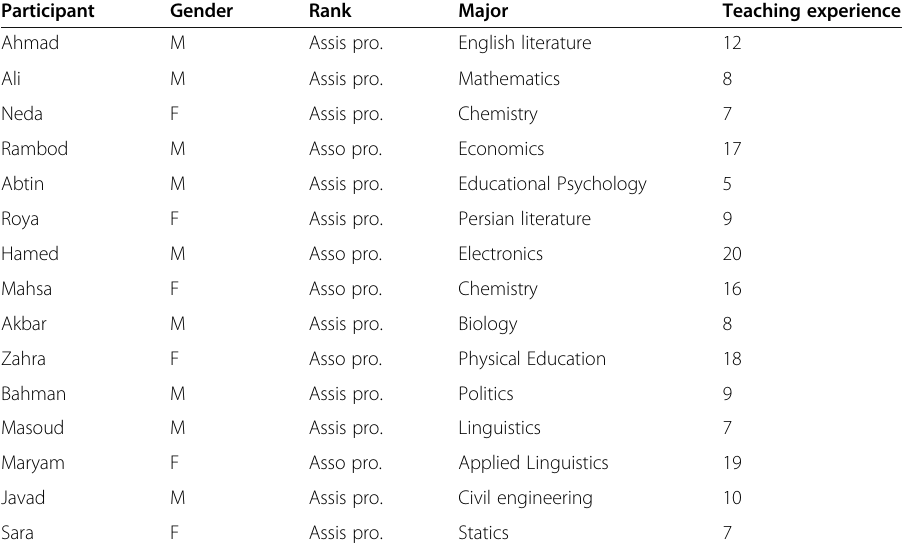
Table 1 Demographic information of the participants